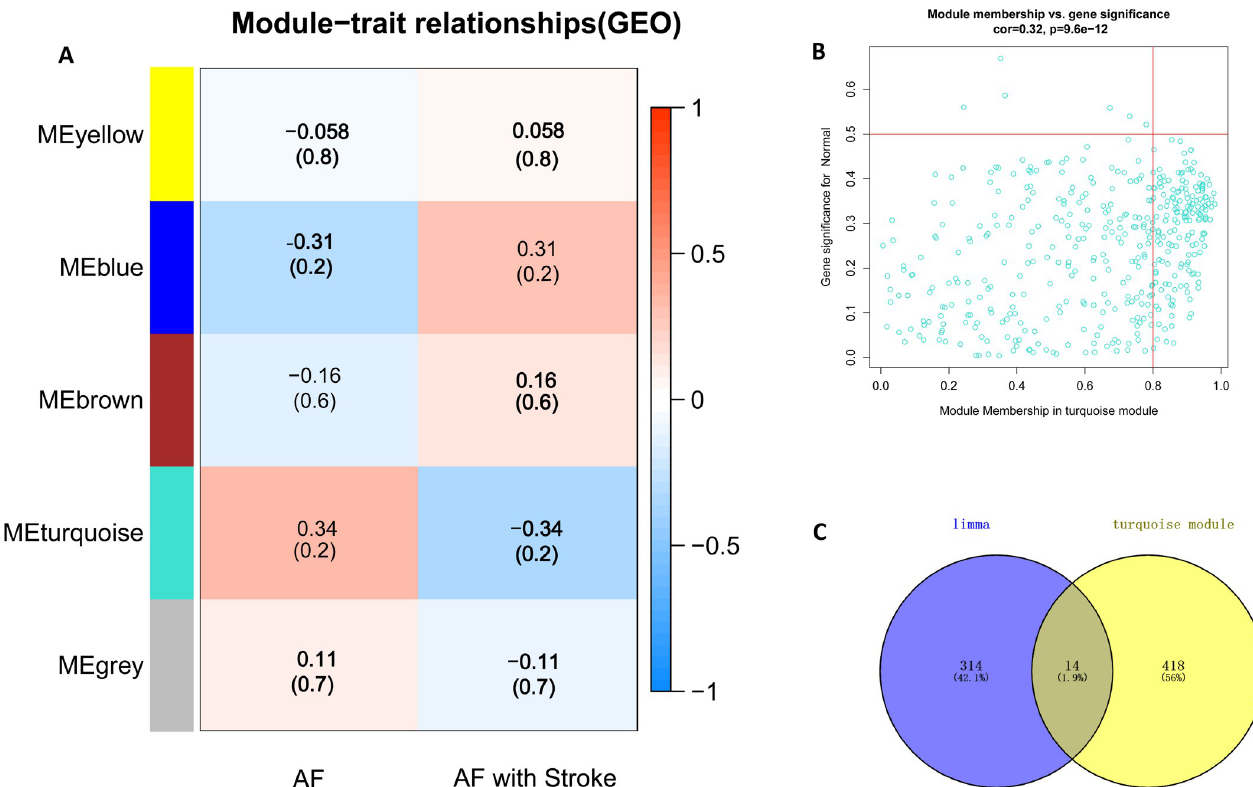
Fig 5. The identification of key modules via weighted gene co-expression network analysis. Heatmap of the correlation between module eigengenes and the disease status of AF-related Stroke (A). The corresponding correlation coefficient along with P-value is given in each cell, and each cell is color-coded by correlation according to the color (legend at right). The turquoise module was most significantly correlated with AF-related Stroke. Scatter plot of module eigengenes in the turquoise module was presented (B). The Venn diagram of genes from the key module and DEGs from GSE66724 was drawn (C).